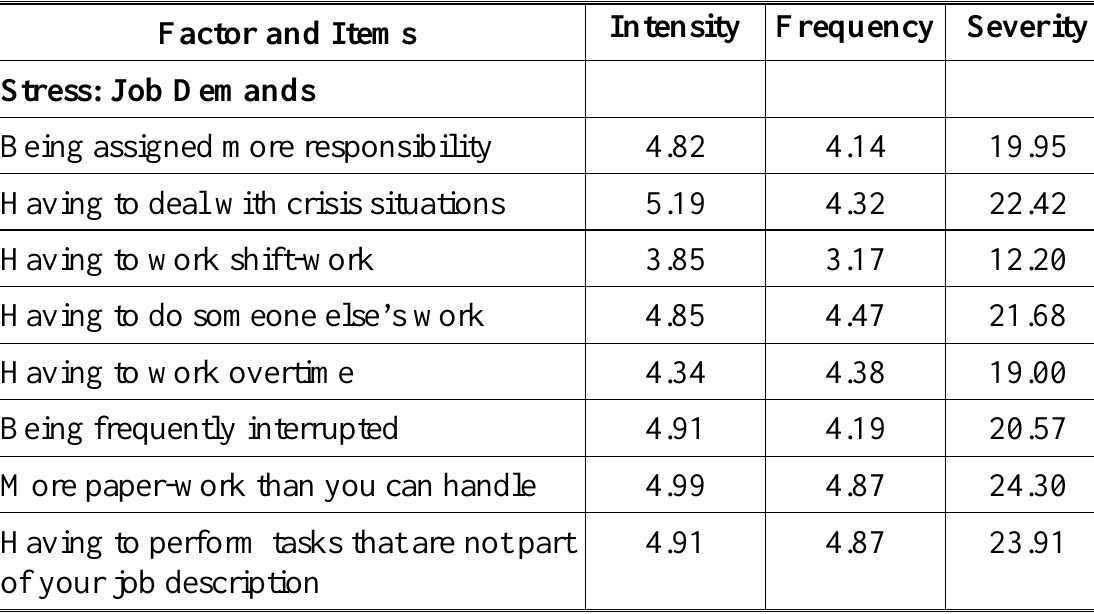
The intensity and frequency of police